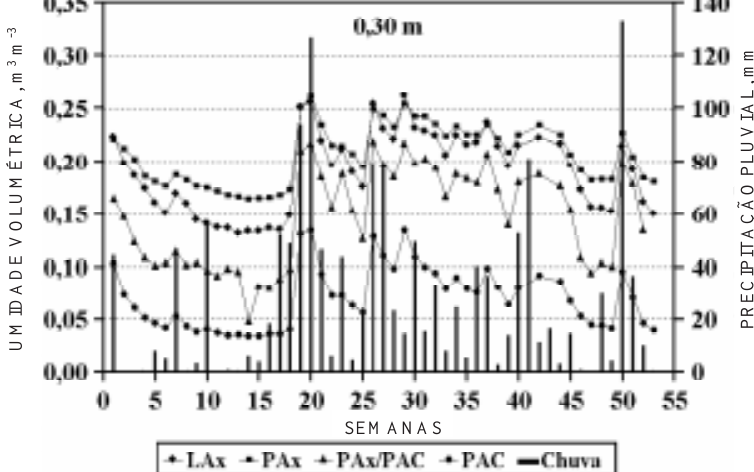
Figura 3. Variação da umidade nos solos Latossolo Amarelo argissólico (LAx), Argissolo Amarelo (PAx), solo transicional PAx/PAC e Argissolo Acinzentado (PAC), nas 53 semanas de avaliação, na profundidade de 0,30 m, e precipitação pluvial no período, em uma toposseqüência em tabuleiro do Estado da